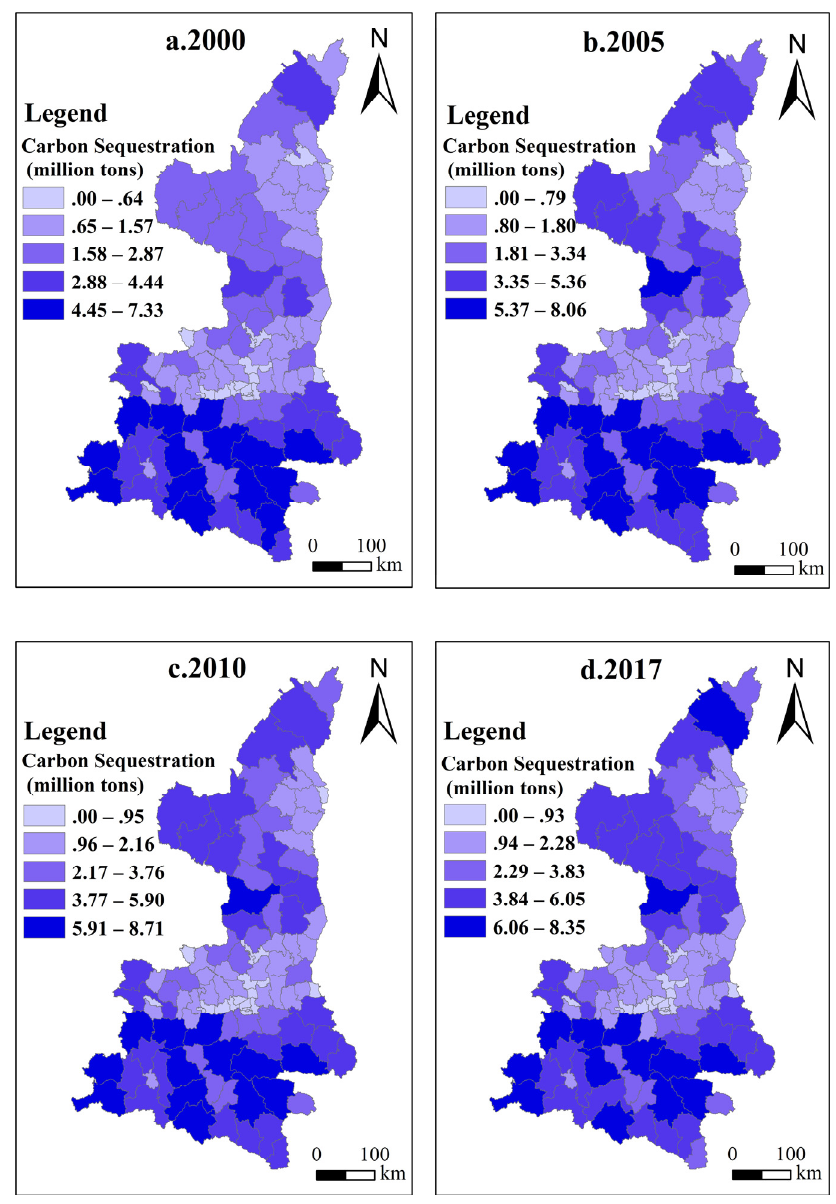
Figure 3. The spatiotemporal evolution of carbon sequestration in Shaanxi Province. ( a ) Carbon sequestration in 2000; ( b ) carbon sequestration in 2005; ( c ) carbon sequestration in 2010; ( d ) carbon sequestration in 2017.